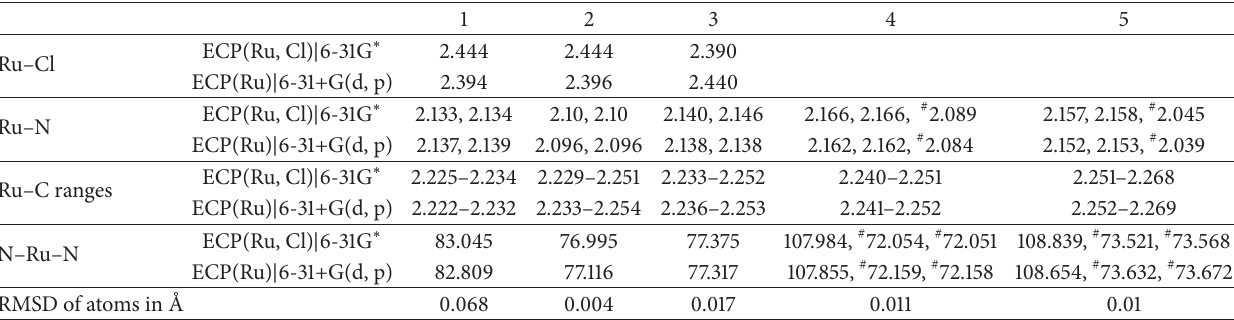
Table 1: The selected bond lengths and angles of interest with the percentage of the alignment of each of the complexes optimized using different basis sets ECP(Ru, Cl) | 6-31G ∗ and ECP(Ru) | 6-31+G(d, p).